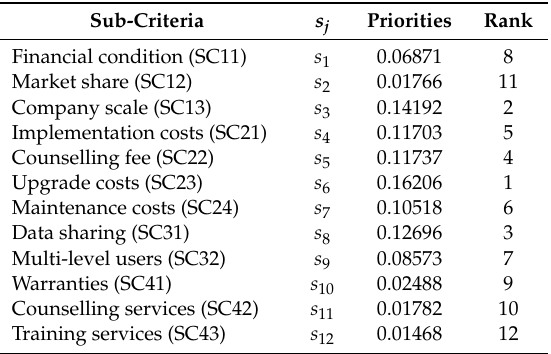
Table 7. Priorities of the sub-criteria.